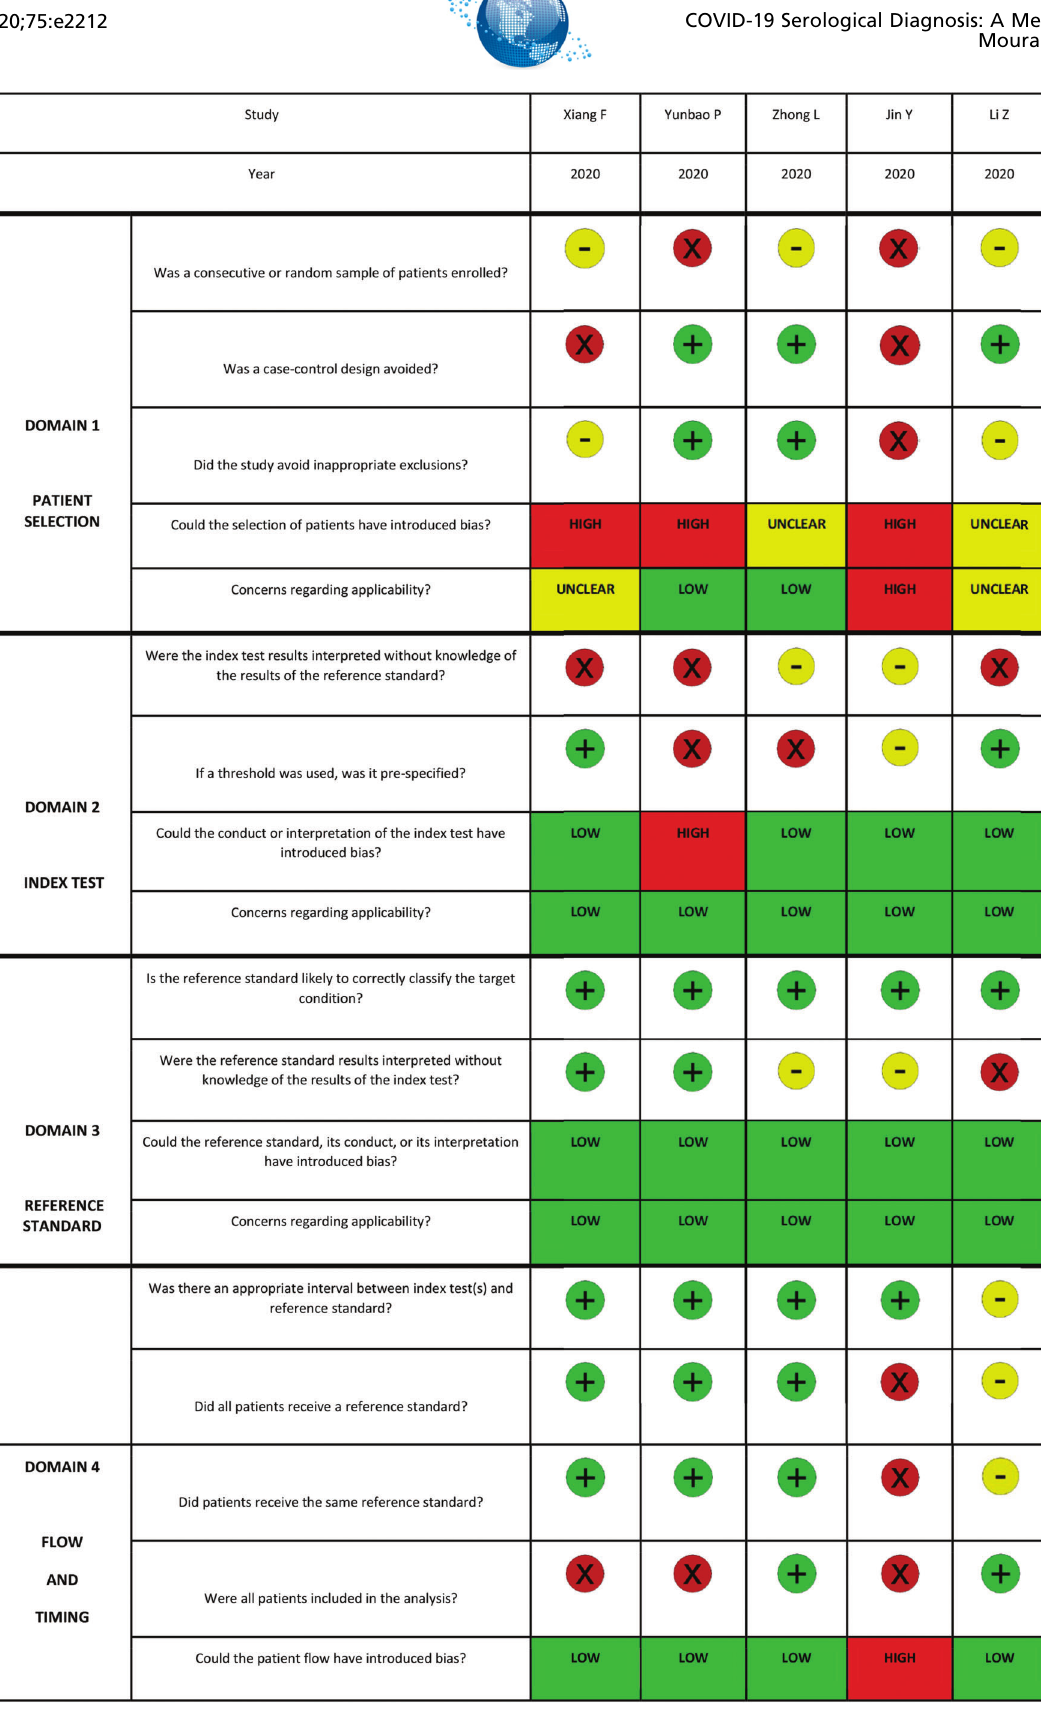
Supplementary File 2 - Risk of bias assessment according to QUADAS-2.